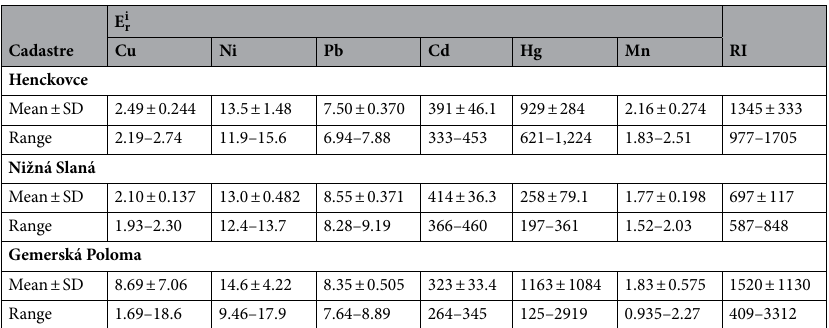
i r ); Potential ecological risk index